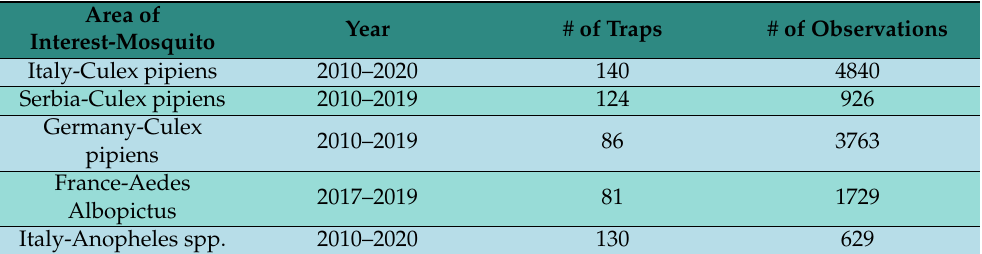
Table 2. Final dataset of each case.